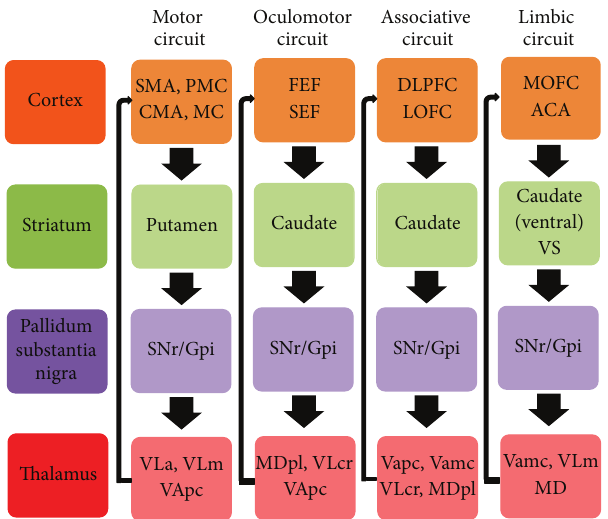
Figure 2: The parallel motor, oculomotor, associative, and limbic circuits of the basal ganglia. ACA: anterior cingulate area; CMA: cingulate motor area; DLPFC: dorsolateral prefrontal cortex; FEF: frontal eye fields; GPi: internal segment of the globus pallidus; LOFC: lateral orbitofrontal cortex; MC: primary motor cortex; MD: mediodorsalnucleusofthethalamus;MDpl:mediodorsalnucleusof thalamus, pars lateralis; MOFC: medial orbitofrontal cortex; PMC: premotor cortex; SEF: supplementary eye field; SMA: supplemen- tary motor area; SNr: substantia nigra pars reticulata; VAmc: ventral anterior nucleus of thalamus, pars magnocellularis; VApc: ventral anterior nucleus of thalamus, pars parvocellularis; VLa: anterior ventrolateral nucleus of the thalamus; VLcr: ventrolateral nucleus of thalamus, pars caudalis, rostral division; VLm: ventrolateral nucleus of thalamus, pars medialis; VS: ventral striatum [12,